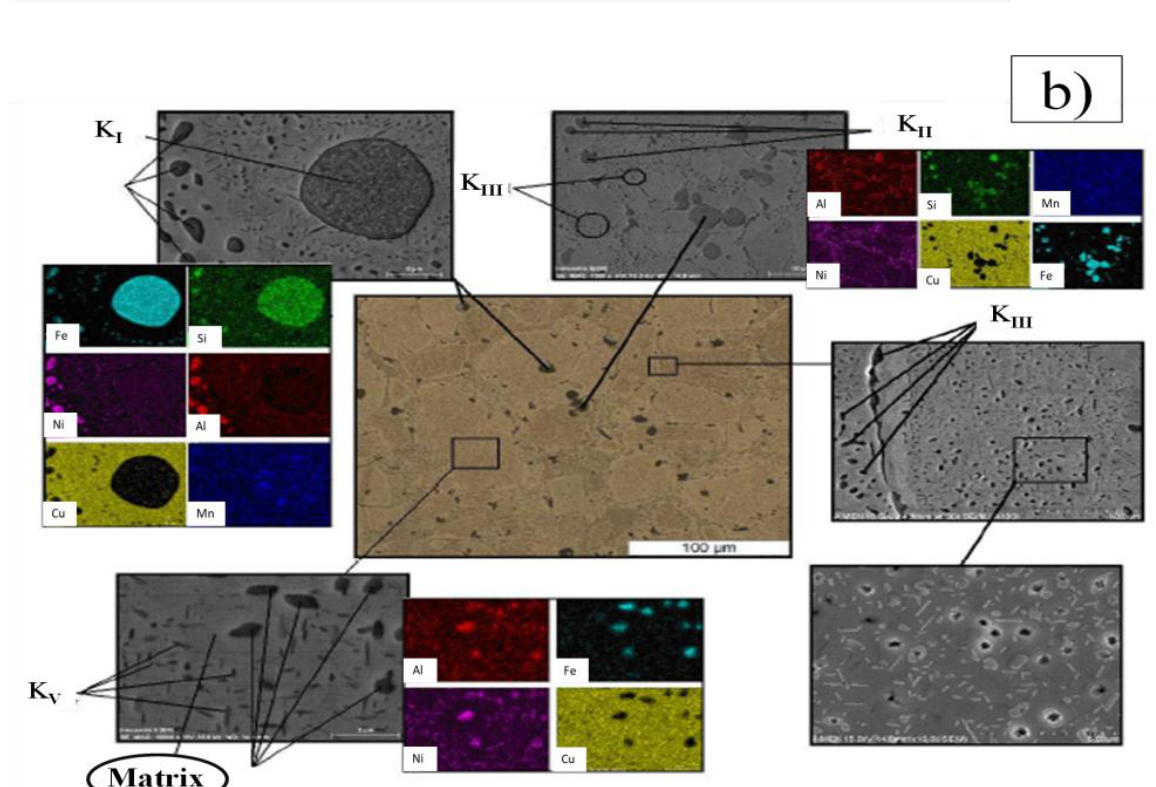
Figure 1. SEM image and phase identification of the ( a ) B (as-cast) samples and ( b ) BR (annealed) samples. See the text for details.